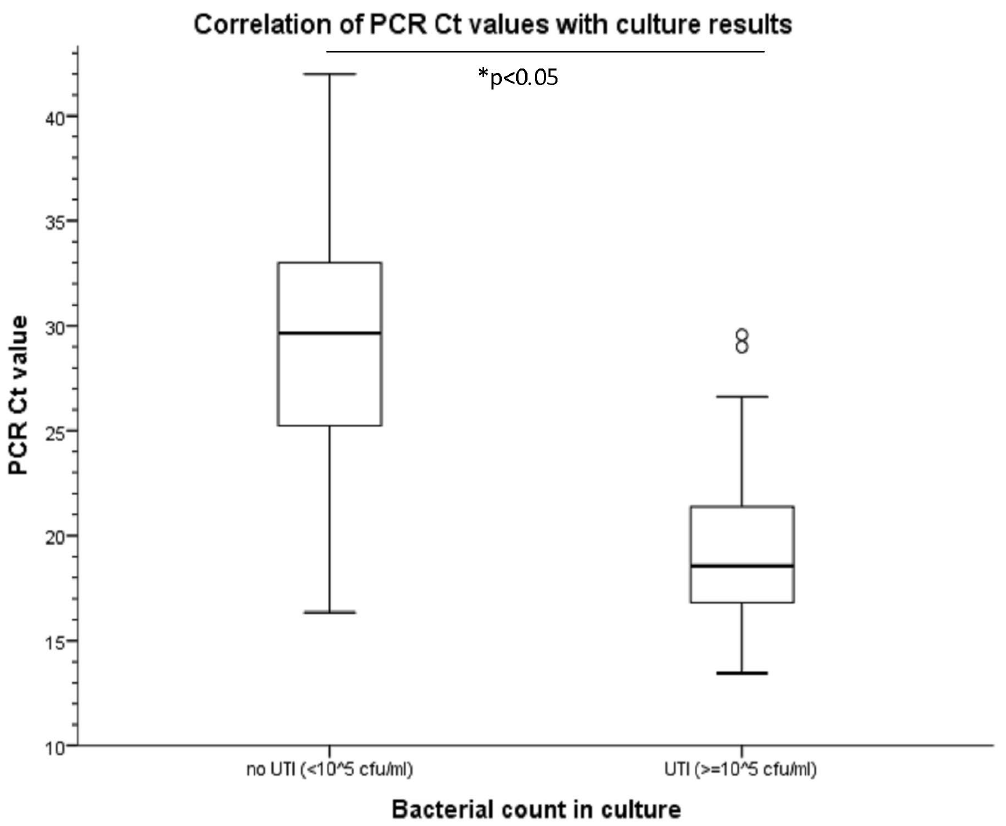
Figure 2. Correlation of PCR Ct values with culture results. Based on culture, samples were categorized into two groups: UTI ( $ 10 5 CFU/ml) and no UTI ( , 10 5 CFU/ml). The universal 16S rDNA probe, of which a Ct value of 25 was set as breakpoint, was used to distinguish between positive and negative samples (line in dots). * p , 0.05 (non-parametric Mann-Whitney Test).